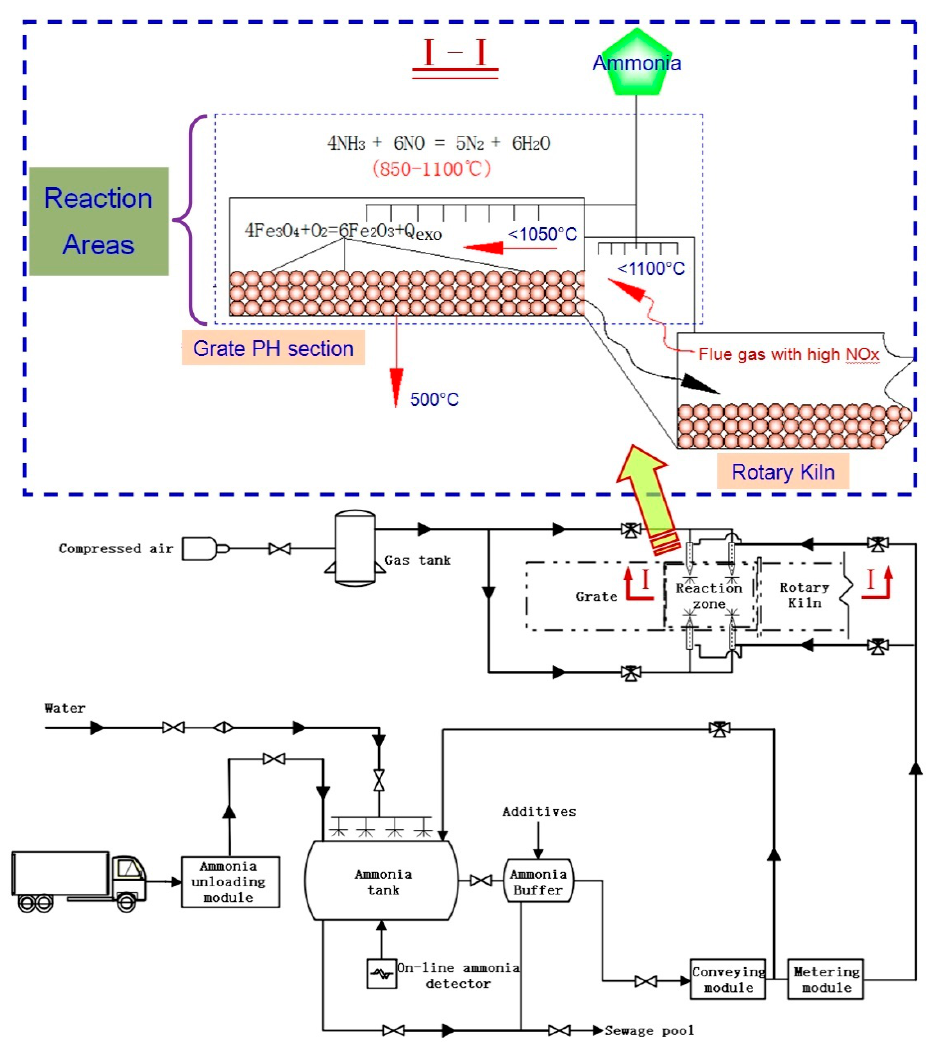
Figure 4. Process flow of advanced reburning denitrification device and its application.